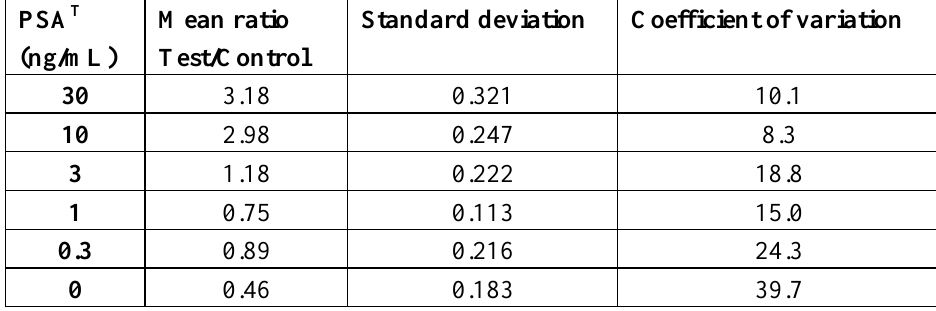
Table 1. Table showing the results obtained in the lateral flow assay measured by RCM expressed as the mean ratio of the test and control line